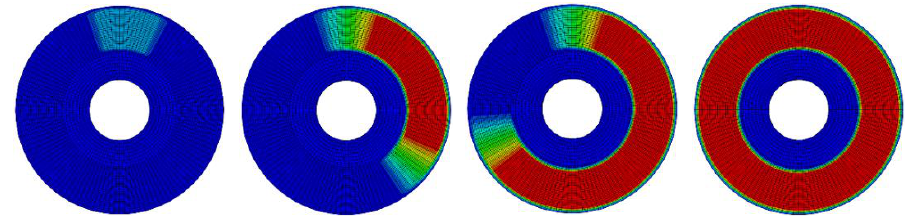
Figure 8. Temperature distribution with equivalent method at different times in one rotation.